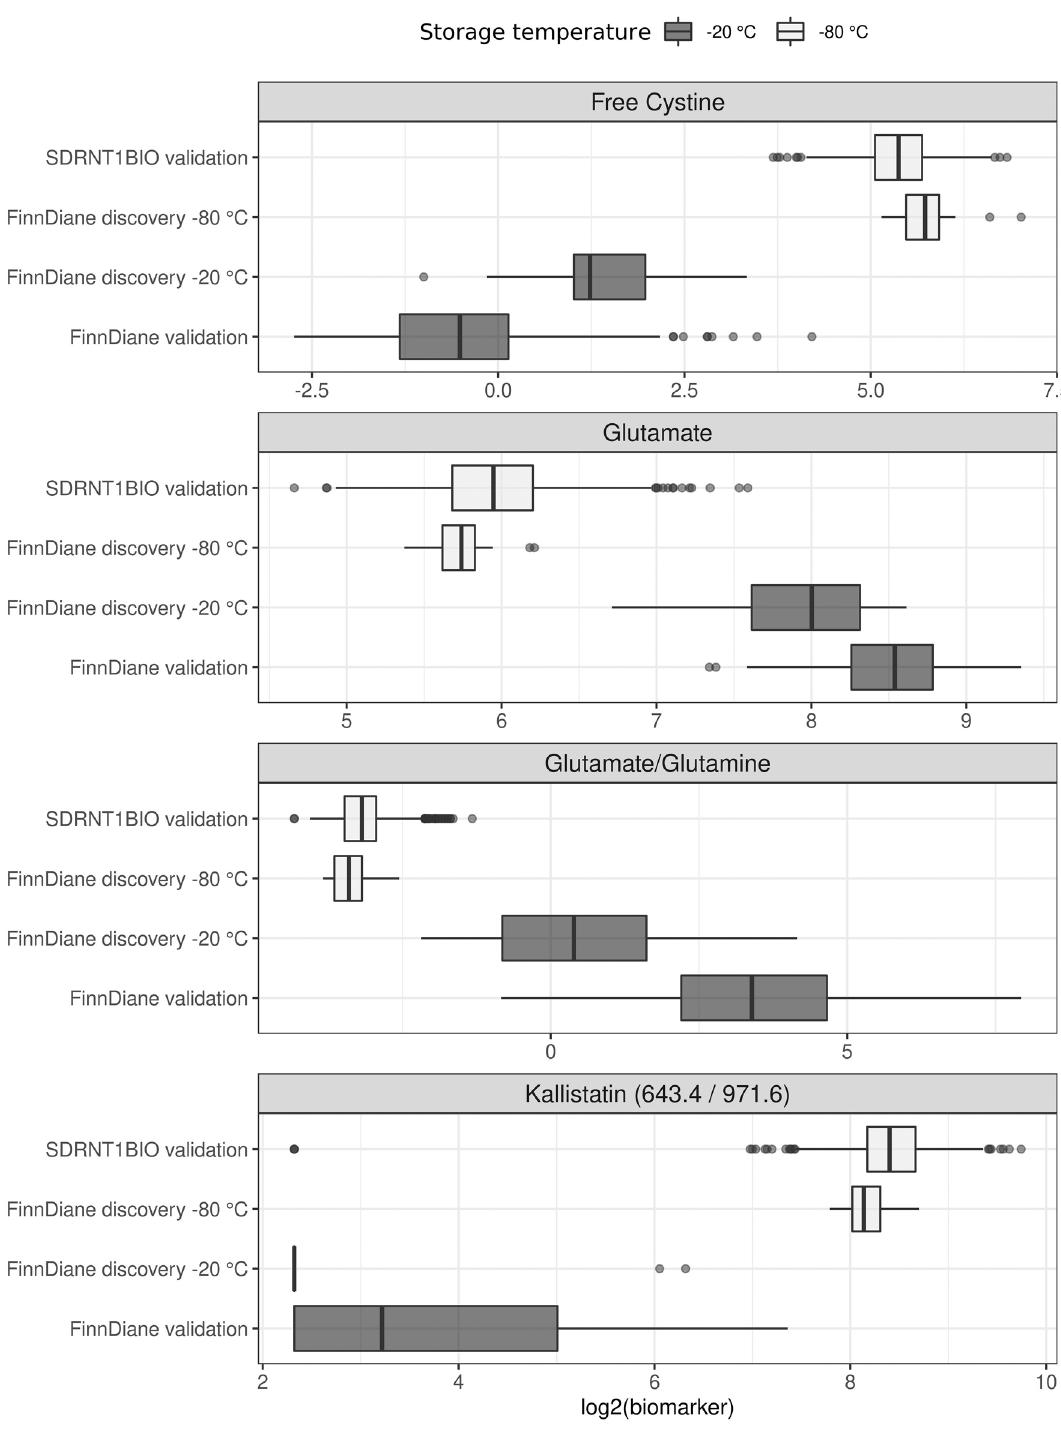
Figure 2. Distribution of log2-transformed values for biomarkers perfectly discriminating between − 20 and − 80 °C samples in the FinnDiane discovery